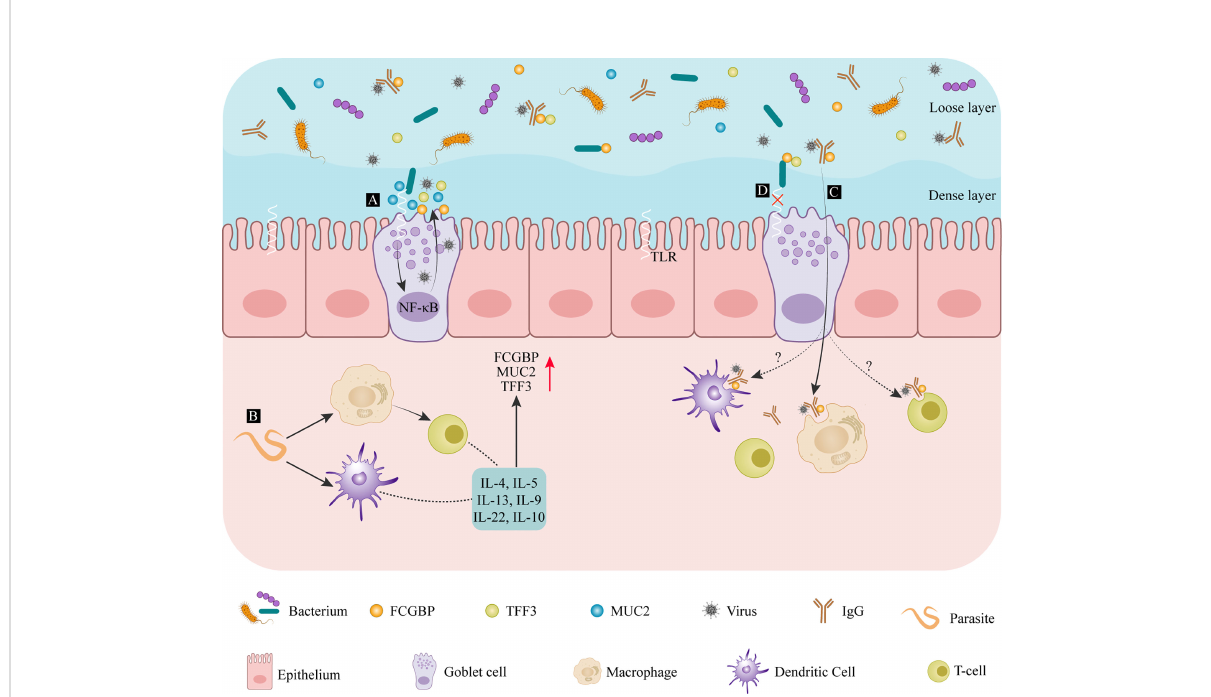
FIGURE 2 The defense mechanism of FCGBP in mucosal diseases of the colon. (A) After entering the intestinal dense mucosa, bacterial compounds bind to Toll-like receptors, activating the NF- k B signaling pathway and promoting further mucus release. (B) After microorganisms, such as parasites, are detected by DCs or macrophages, their antigens are presented to T cells where they induce cytokines such as IL-13 and other cytokines secretion, promoting FCGBP production. (C) After FCGBP interacts with an IgG antigen complex, it is transported across the mucosa and is recognized by macrophages. (D) FCGBP-TFF3 complexes bind to bacteria to prevent them from passing through the epithelial barrier. IL, interleukin; FCGBP, IgGFc-binding protein; MUC2, mucin-2; TFF, trefoil factor family; TLRs, Toll-like